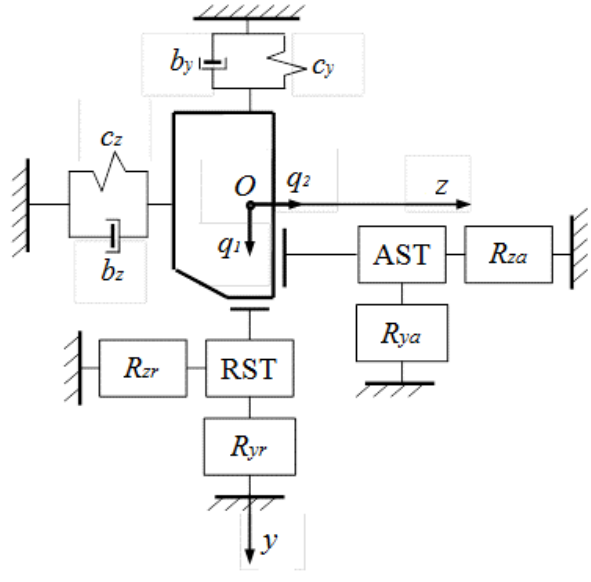
Figure 2. Rheological presentation of force interactions in the cutting